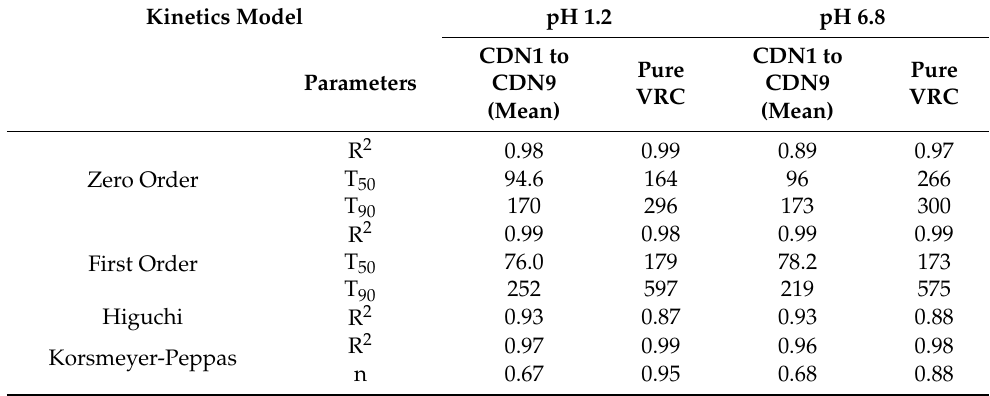
Table 4 Drug release kinetics results of CD nanobeads and pure VRC at pH 1.2 and pH 6.8. Table 4. Drug release kinetics results of CD nanobeads and pure VRC at pH 1.2 and pH